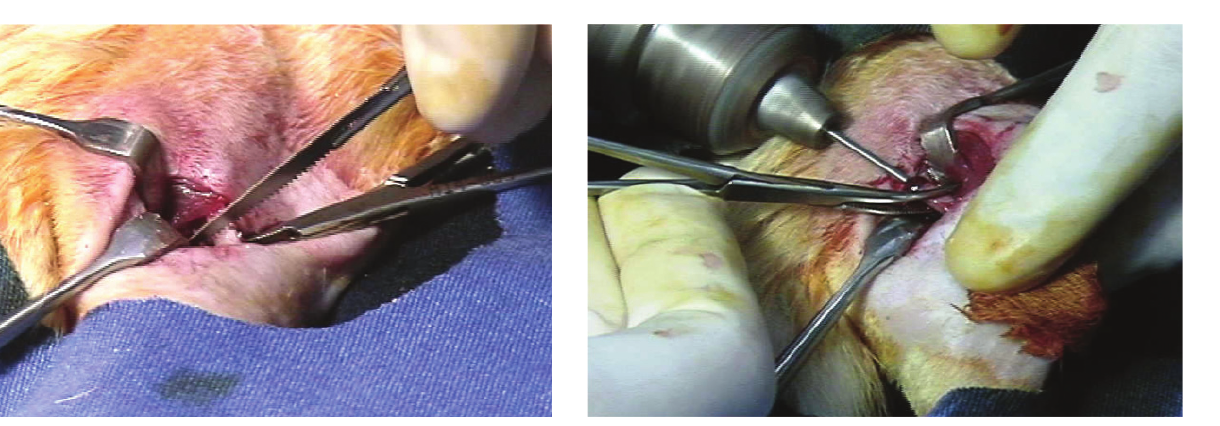
Figure 1 - Femur osteotomy with manual saw